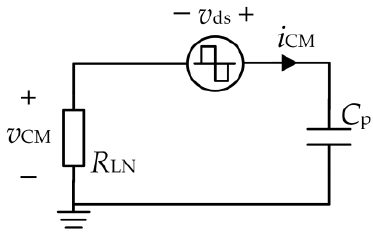
Figure 4. Equivalent circuit of CM EMI.